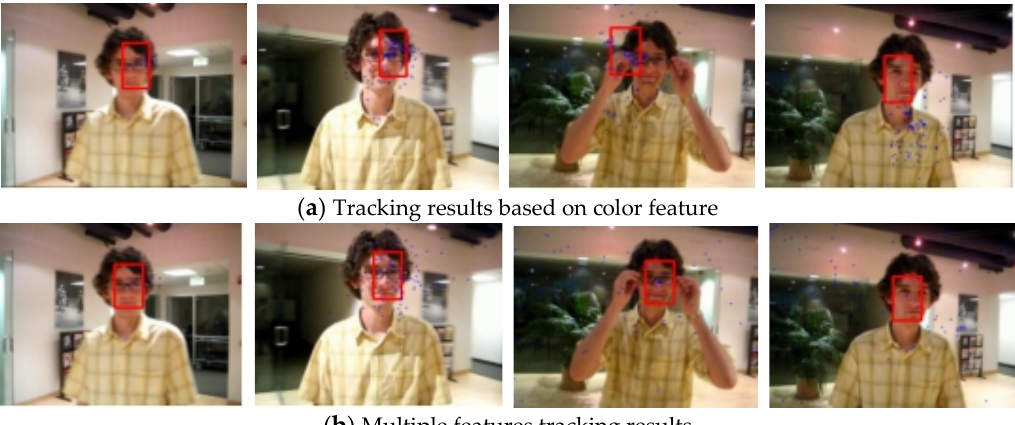
Sensors 2019 , 19 , x FOR PEER REVIEW Figure 5. Tracking results under the background changes. Figure 5. Tracking results under the background changes.